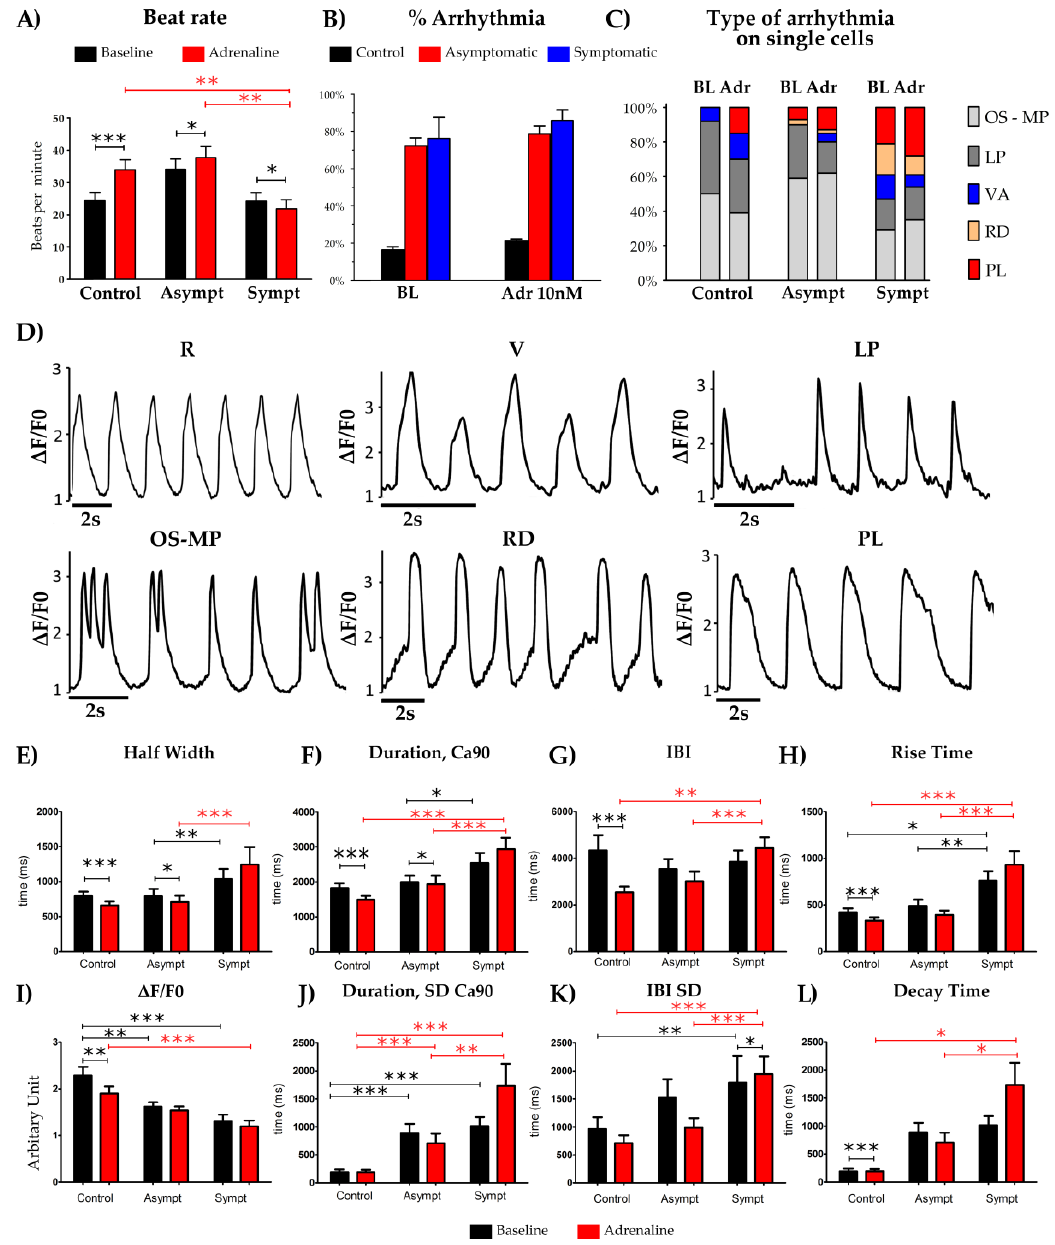
Fig 3 Figure 3. LQT2 hiPSC-CM shows increased calcium transient abnormalities. ( A ) Response of the control, the LQT2 asymptomatic and the symptomatic hiPSC-CMs to application of 10 nM adrenaline. ( B ) Percentage of CMs showing arrhythmia at baseline (BL) and during 10 nM adrenaline (Adr 10nM) perfusion. ( C ) Comparison of type of arrhythmia observed at baseline and under adrenaline (Adr) in the control, the LQT2 asymptomatic and the symptomatic CMs. ( D ) Representative arrhythmia observed in the control, the LQT2 asymptomatic and the symptomatic hiPSC-CMs Ca 2 + transients. LQT2 asymptomatic CMs have most occurrences of oscillations and low amplitude peaks, while symptomatic CMs have quite equal amounts of all the five kinds of abnormalities but more delay in rise and decay phase than the LQT2 asymptomatic. RG = Regular, OS = oscillations and multiple peaks, LP = low amplitude peaks, PL = plateau abnormality / delay in decay, RD = rise delay, VA = varying amplitude. ( E – L ) Ca 2 + imaging parameters at baseline and in the presence of 10 nM adrenaline. Data is presented for n = 68, 78, 44 for the control, the LQT2 asymptomatic, and the symptomatic respectively, as the mean ± SEM, (*) p < 0.05, (**) p < 0.01 and (***) p <